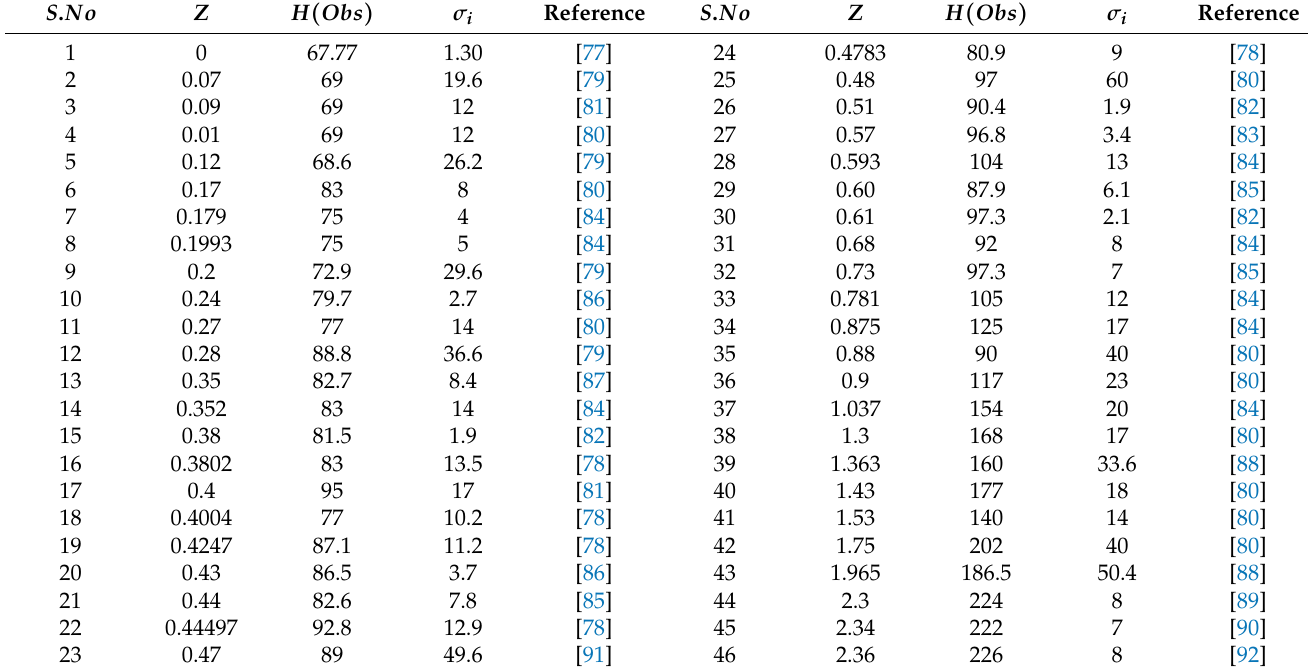
Table 1. The behavior of Hubble parameter H ( z ) with